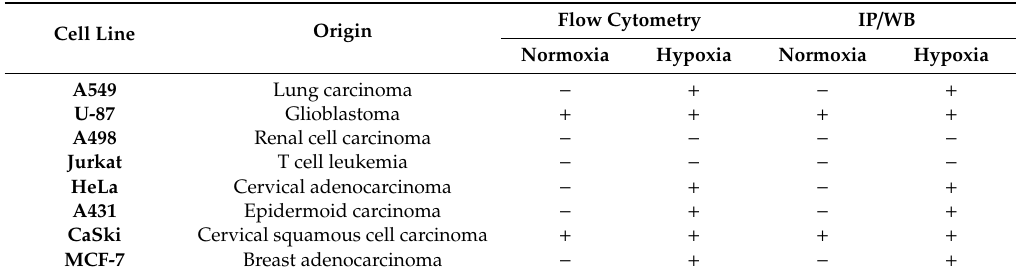
Table 3. Comparison of CA IX expression in human cancer cells grown in normoxic and hypoxic conditions determined with specific MAbs by flow cytometry and IP /